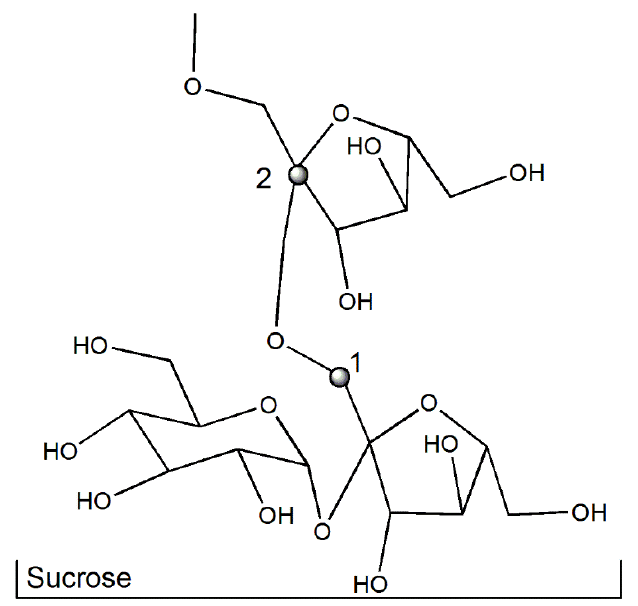
Figure 9. Base structure of fructo-oligosaccharides with β-(2,1)-bound fructose